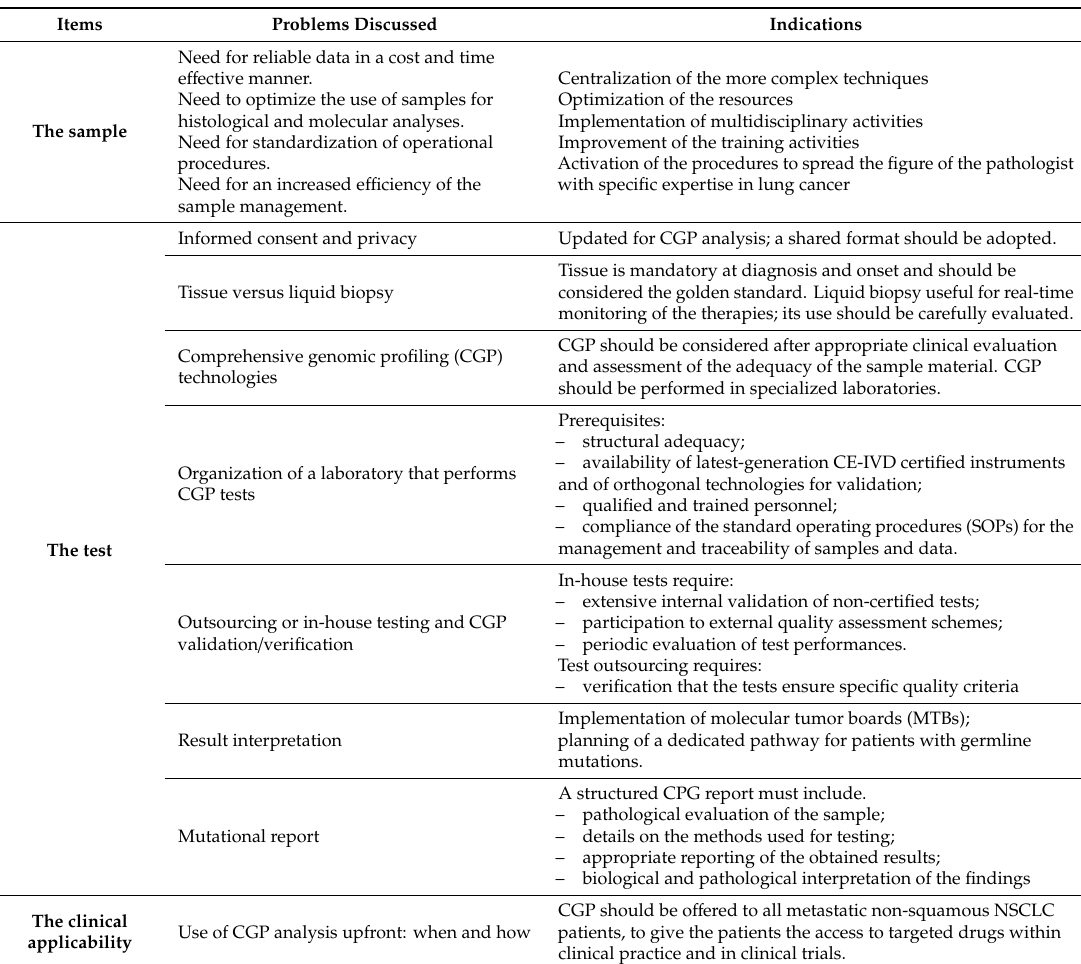
Table 1. Summary of the indications of the AIOT Expert